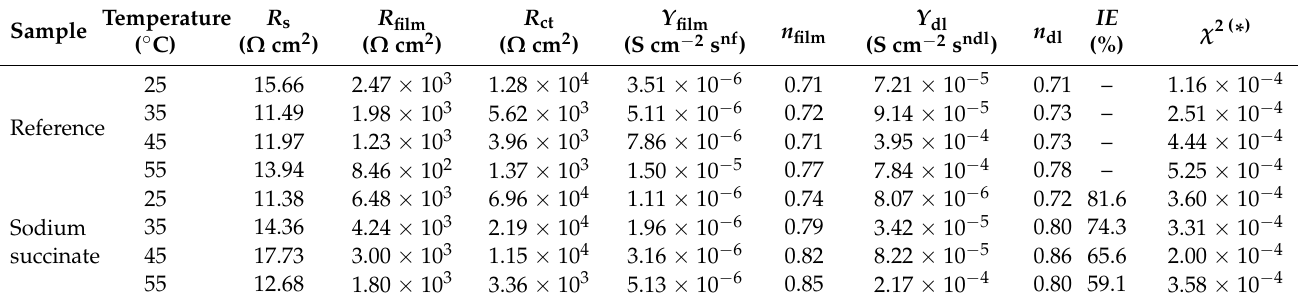
Table 2. EIS electrochemical parameters of carbon steel in 0.6 M Cl − SCPS in the absence and presence of 0.6 M sodium succinate at 25, 35, 45, and 55 °C.